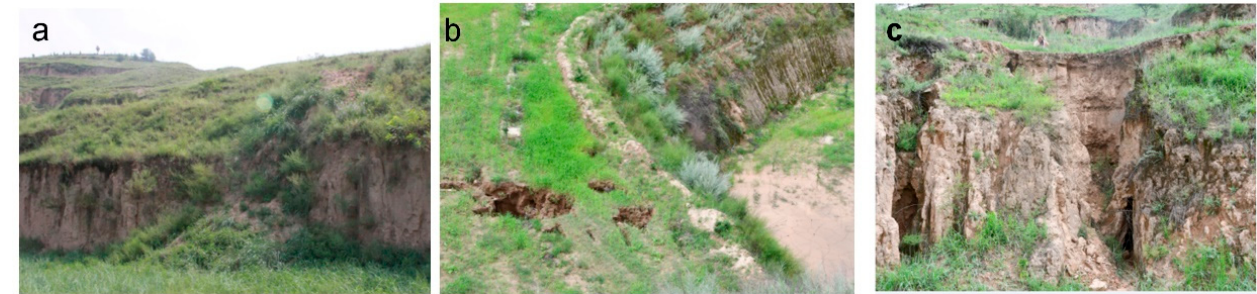
Figure 1. Terrace damages found by our field investigation. The damages generally include ( a ) collapse; ( b ) terrace sinkhole; and ( c ) ridge sinkhole.